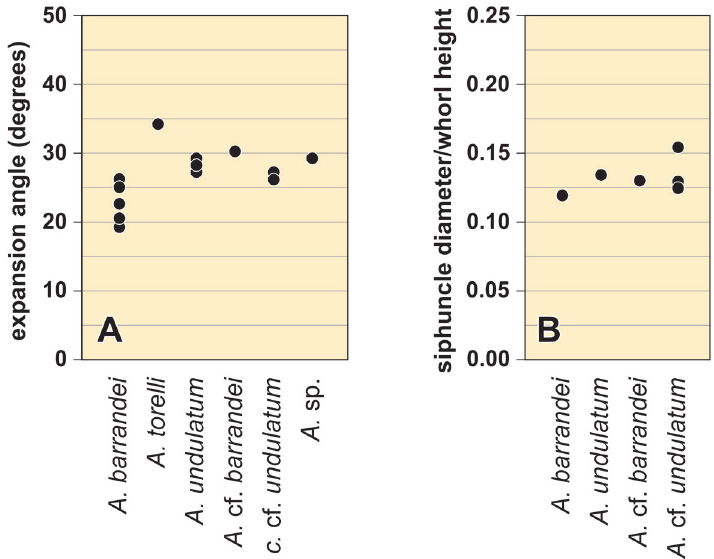
Fig. 19. Conch expansion rates (A) and siphuncle diameter rates (B) in species of Ancistroceras Boll,